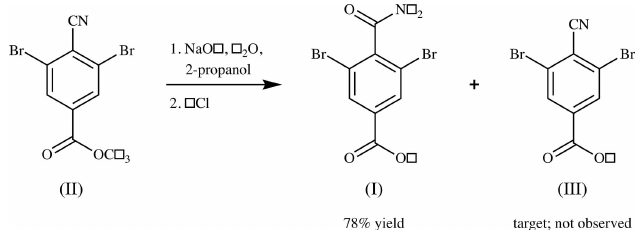
Figure 1 The synthesis of (I).